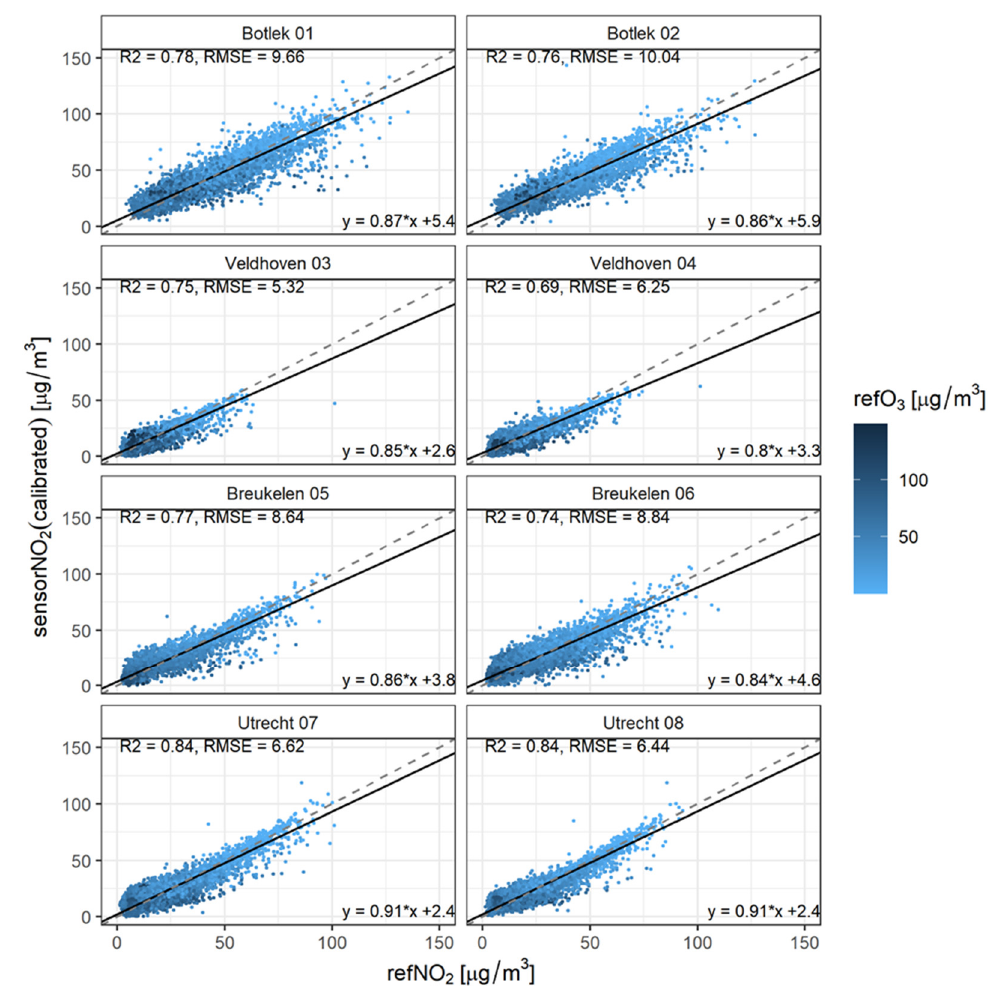
Figure 5. Like Figure 3 but this time for calibration: refNO 2 ~sensorNO 2 , sensorT, refO 3 . The colors correspond to the ambient O 3 concentration.